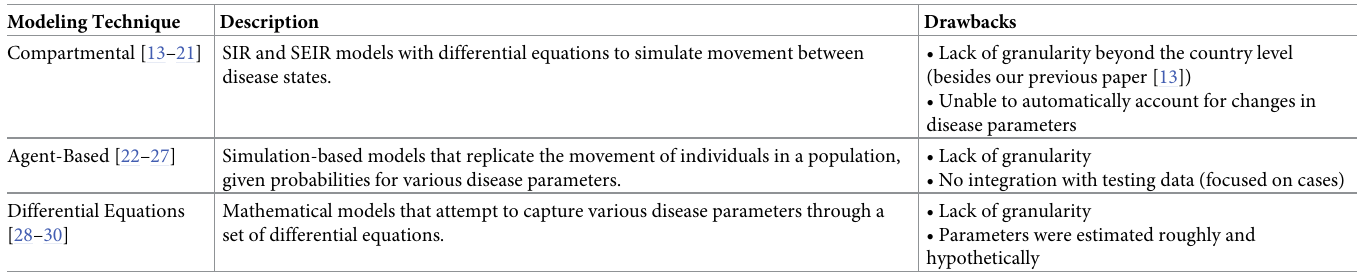
Table 1. Comparison of related COVID-19 modeling